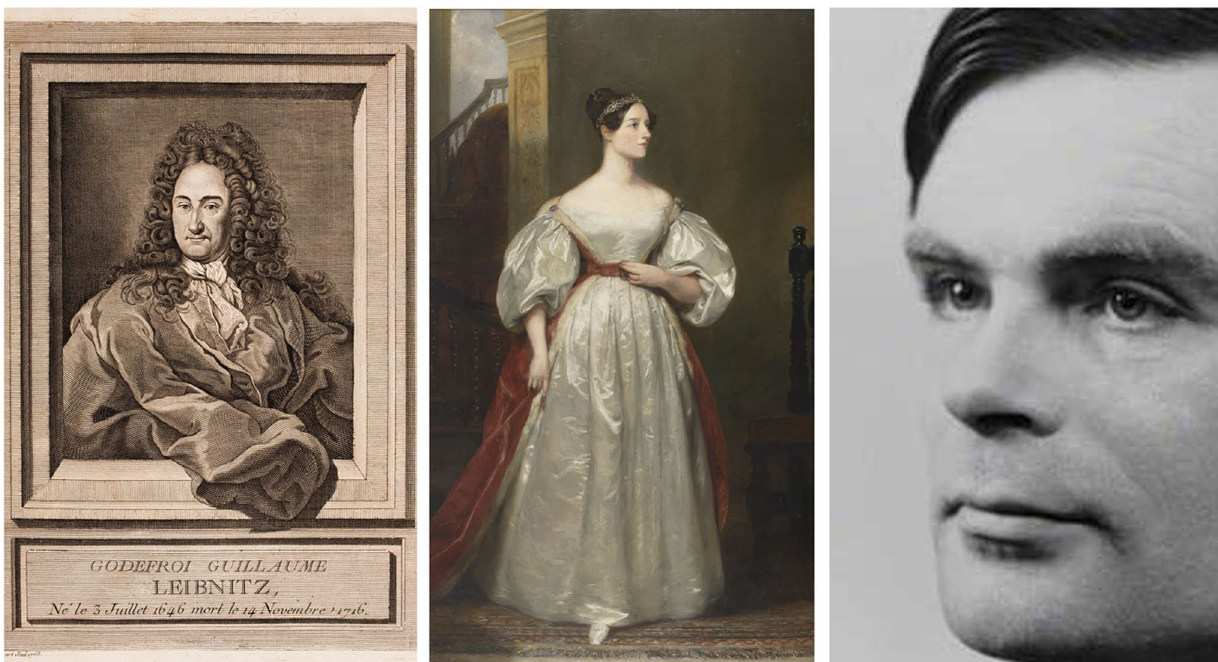
Fig. 2 Gottfried Leibniz: “Let us calculate”; Ada Lovelace: “algebraical patterns”; Alan Turing: “Can Machines